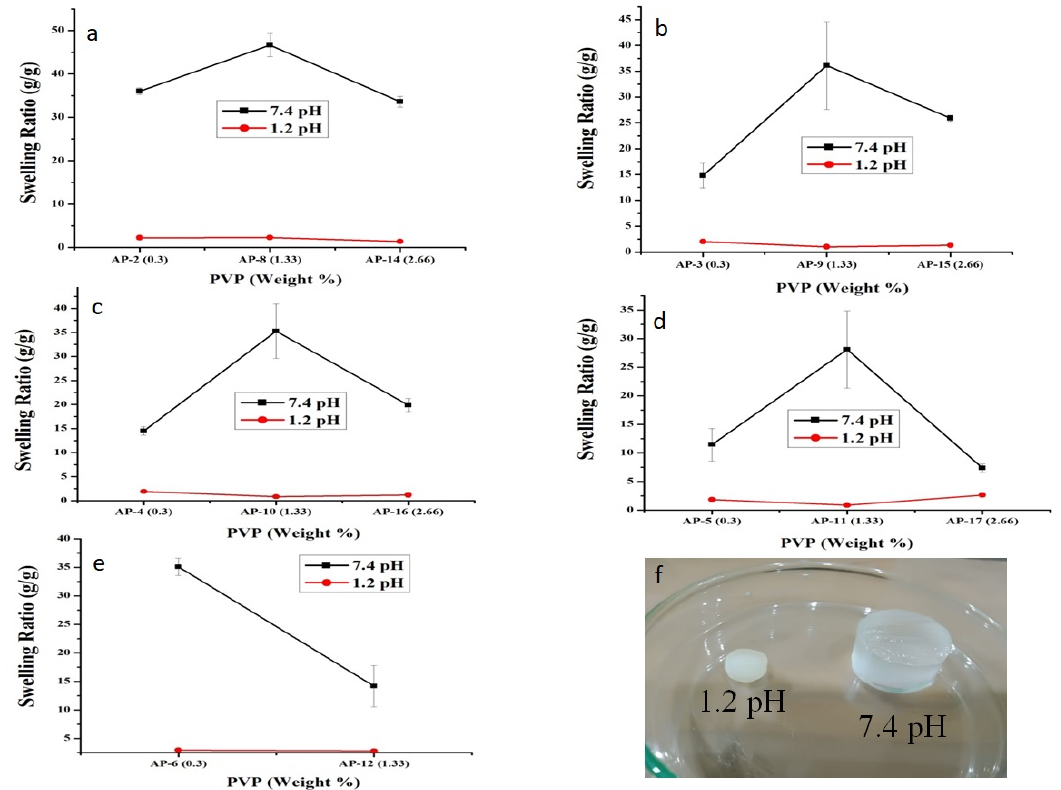
Figure 3. Impact of PVP concentration on equilibrium swelling ratio (g/g) at pH values of 1.2 and 7.4. HP- β -CD remained constant while varying the concentrations of AA, i.e., ( a ) 16.66 g, ( b ) 33.33 g, ( c ) 50 g, ( d ) 66.66 g, and ( e ) 83.33 g. ( f ) Physical appearance of AP-8 at pH values of 1.2 and 7.4. Error bars represent standard deviation ( n = 3).